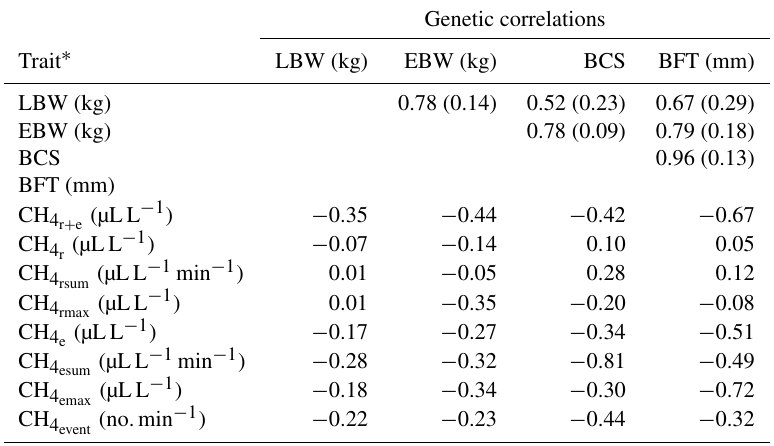
Table 4. Genetic correlations between lamb body weight (LBW), ewe body weight (EBW), ewe body condition score (BCS) and ewe backfat thickness (BFT) with standard errors (in brackets), and approximated genetic correlations between LBW, EBW, BCS, BFT and CH 4 traits. Genetic